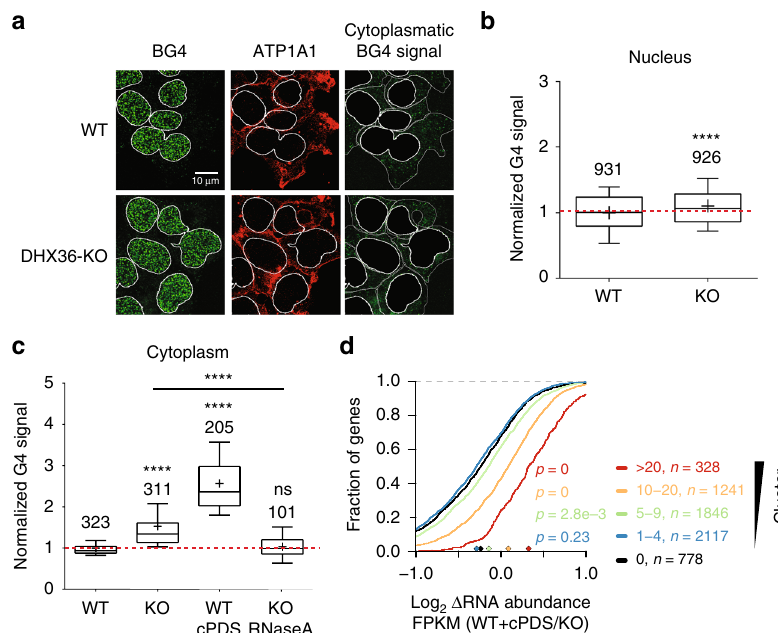
Fig. 6 DHX36 is involved in resolving of rG4s in living cells. a DHX36 loss results in increased cytoplasmic rG4 signal, revealed by labeling of wild-type and DHX36-KO HEK293 cells with the BG4 antibody (green). Anti-alpha 1 sodium potassium ATPase (ATP1A1) served to mark the cytoplasm (red) and allow removal of the nuclear signal. Panels with masked nuclear signal allow visualization of the increased BG4 signal in the cytoplasm in DHX36-KO cells. Scale bar, 10 µ m. b Nuclear G4 levels determined by fl uorescence intensity of cells normalized over WT. Mean of two biological replicates. Numbers indicate analyzed nuclei. Horizontal lines and plus signs represent median and mean values, respectively. Error bars show the distribution from the 10th to 90th percentile. Signi fi cance was determined using a two-sided KS test (* P < 0.05; **P < 0.01; *** P < 0.001; **** P < 0.0001). c Same analysis as in b , except fl uorescence intensity of the cytoplasmic compartment was calculated by subtracting the nuclear signal from total cell fl uorescence. If applied, additional treatment of samples is indicated. d Stabilization of G4 structures using carboxypyridostatin (cPDS) in HEK293 cells results in the accumulation of DHX36- E335A PAR-CLIP targets to a larger degree than DHX36-KO as shown by CDFs comparing changes in target mRNA abundance of DHX36 knockout cells ( n = 3) and parental HEK293 cells treated with cPDS ( n = 3). Target mRNAs were binned in accordance to the number of binding sites obtained by DHX36-E335A PAR-CLIP. Signi fi cance was determined using a two-sided KS test. Source data are provided as a Source Data fi